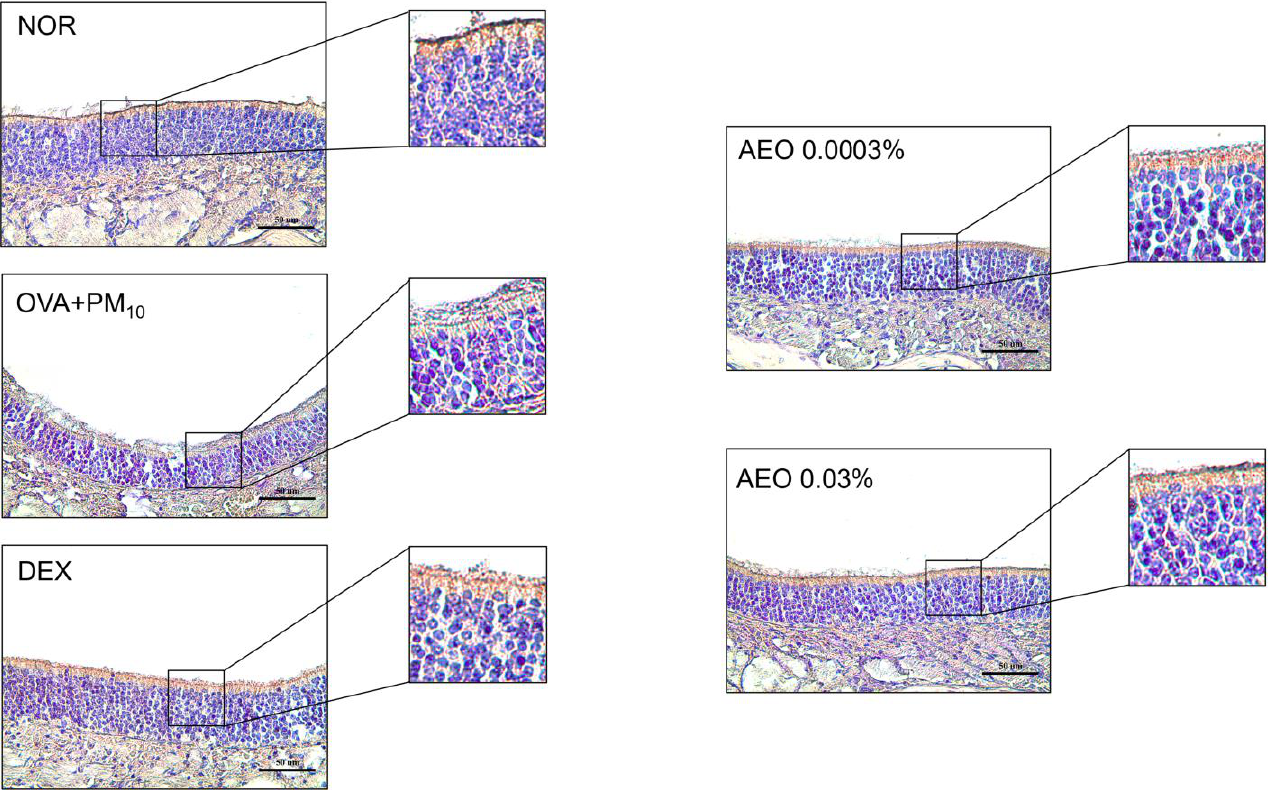
Figure 9. AEO increased expression of ZO-1 in OVA+PM 10 -induced allergic rhinitis mice. The ex- pressions of ZO-1 were analyzed by immunohistochemistry. Tissue sections were observed under a microscope (magnification